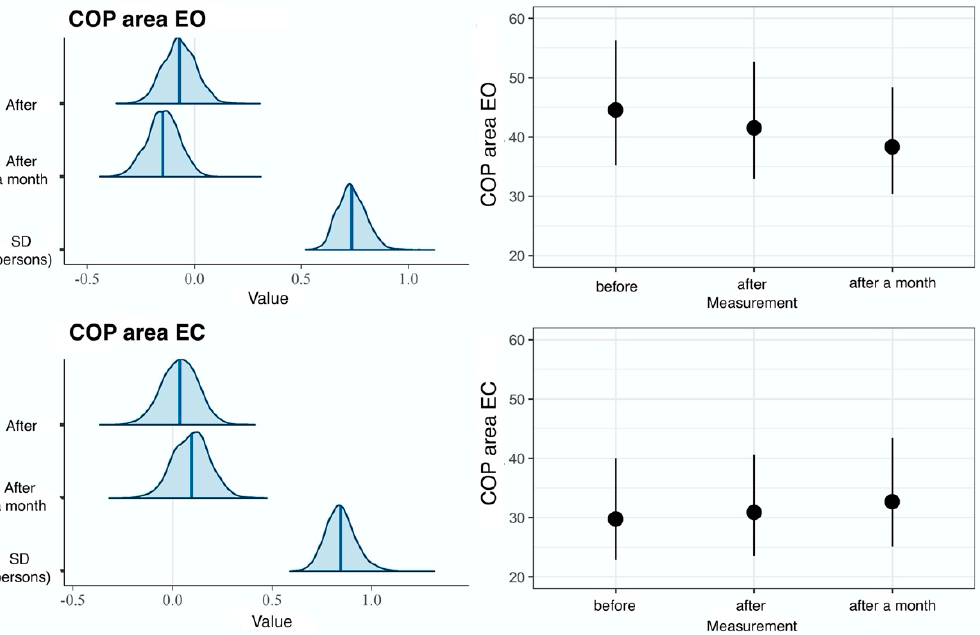
Figure 7. Results of hierarchical two-dimensional regression analysis: the dependent variable is the COP-SA, and the main effect is the measurement in the experimental group. Left panels: a posteriori distributions of regression coefficients. Shaded areas denote 95% confidence level. Right panels: estimated marginal means. The points denote a posteriori distribution mean values, and vertical lines represent 95% confidence intervals. COP—center of pressure; EO—eyes open; EC—eyes closed.